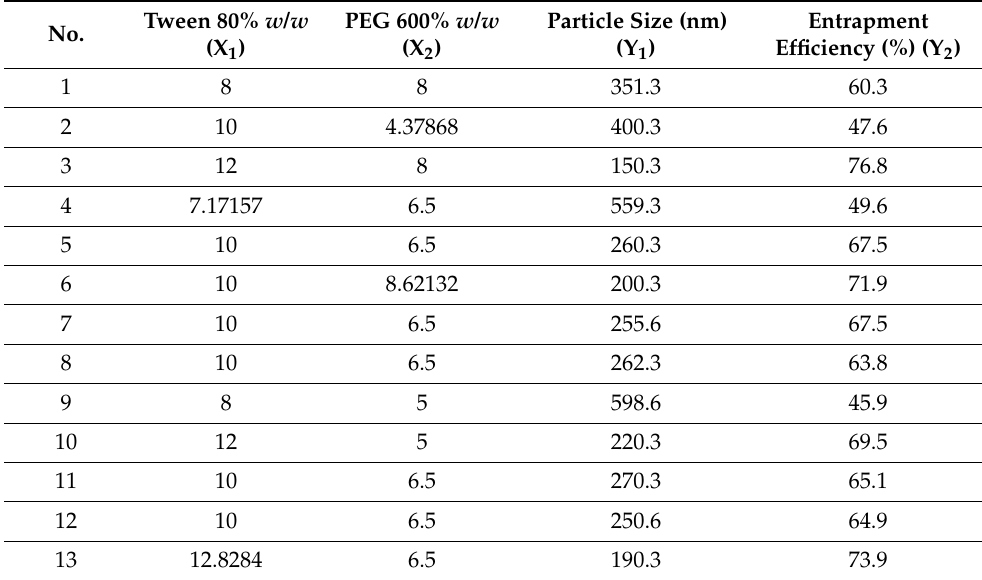
Table 2. Designed CSLN formulations and their response parameters using